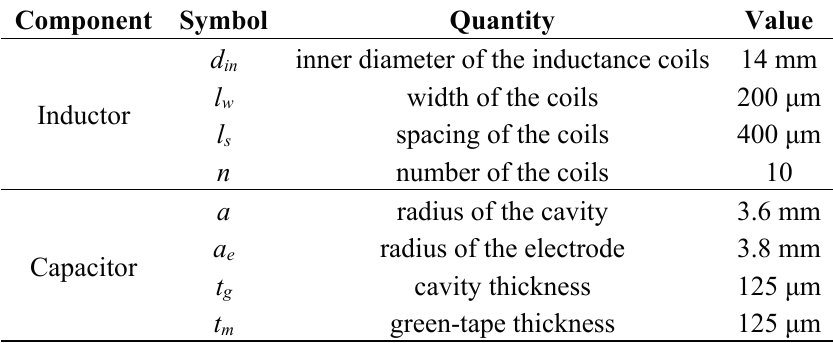
Table 2. Geometrical parameters in inductor and capacitor